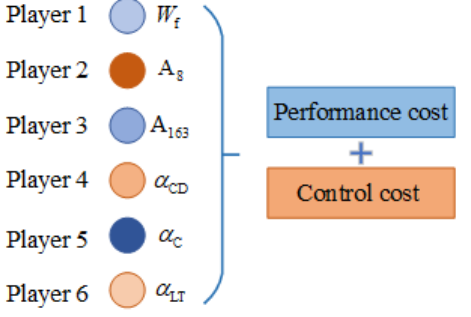
Figure 6. Schematic diagram of the collaboration game.